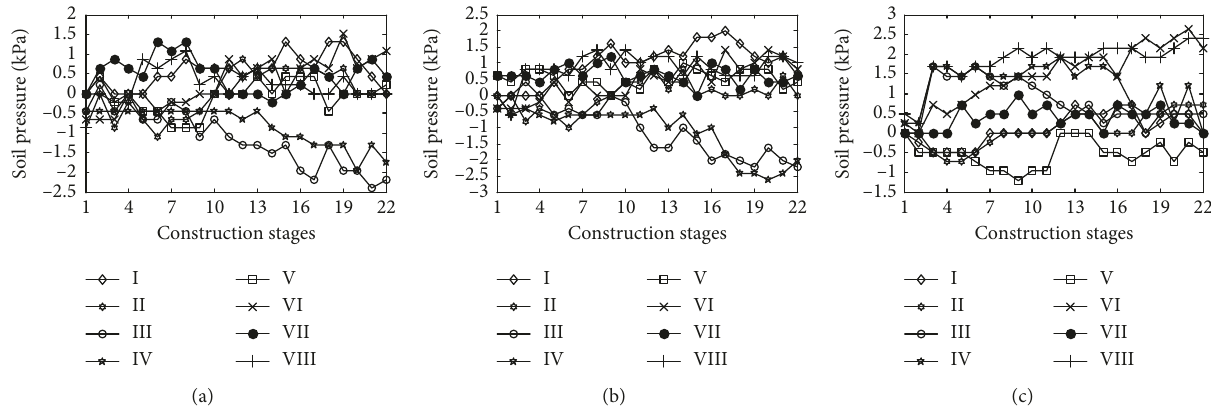
Figure 20: Comparison of soil pressure below the right building foundation. (a) 111. (b) 115. (c)